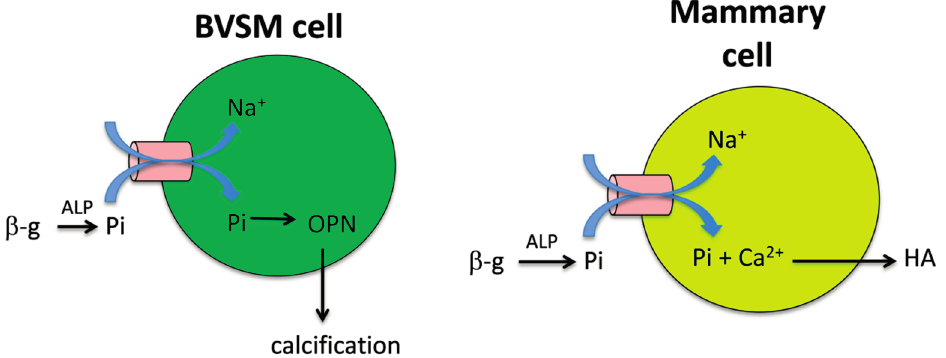
Figure 3. In bovine vascular smooth muscle (BVSM) cell and mammary cells,